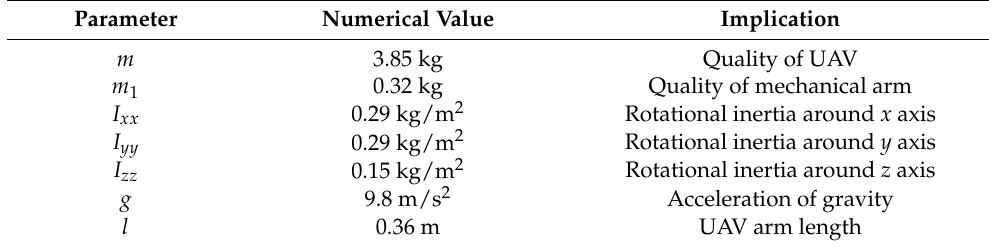
Table 1. Main parameters of the aerial